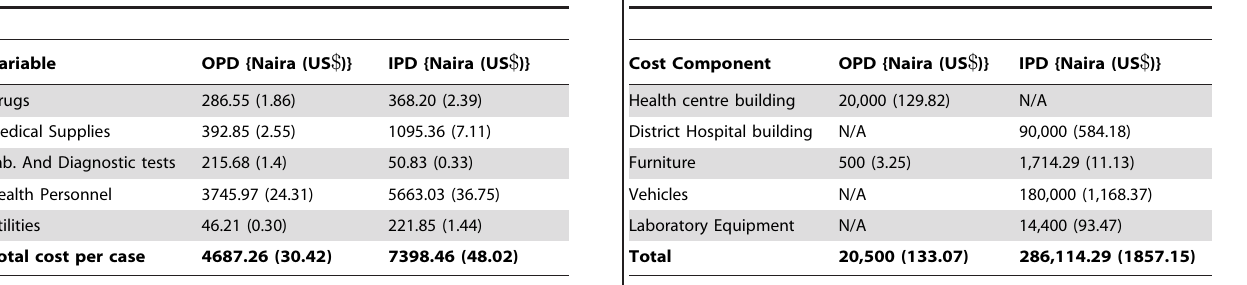
Table 4. Cost per case for OPD (n=125) and IPD (n=125). Table 5. Annual capital cost for OPD and